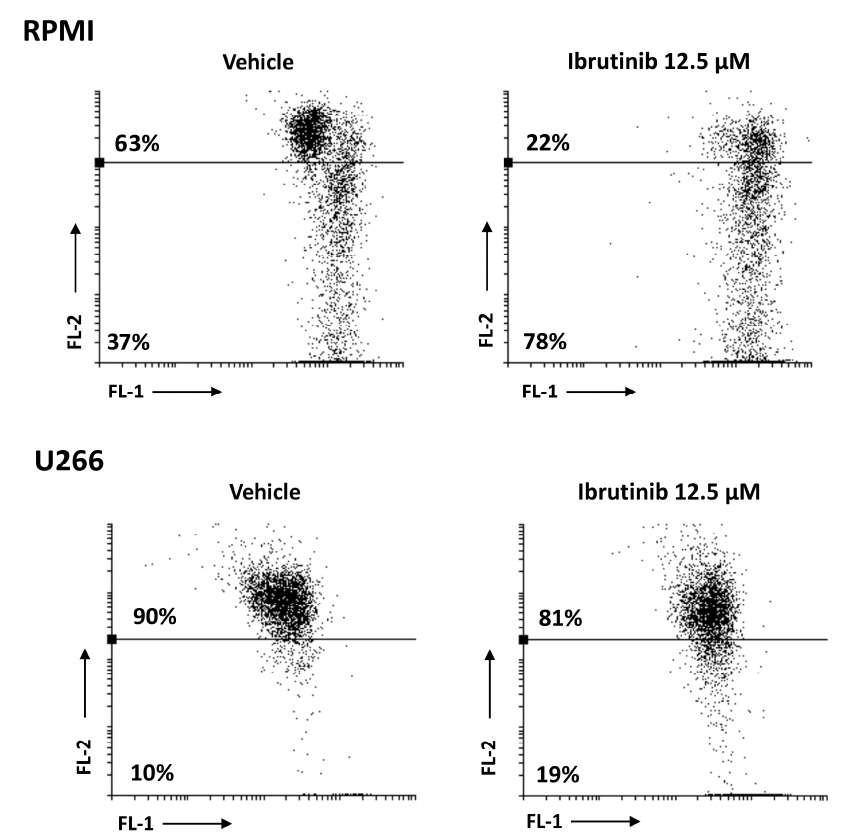
Figure 4. RPMI and U266 were treated with Ibrutinib and the Δψ m changes were evaluated by JC-1 staining and biparametric FL-1(green)/FL-2(red) flow cytometric analysis. Data are representative of one out of three separate experiments.